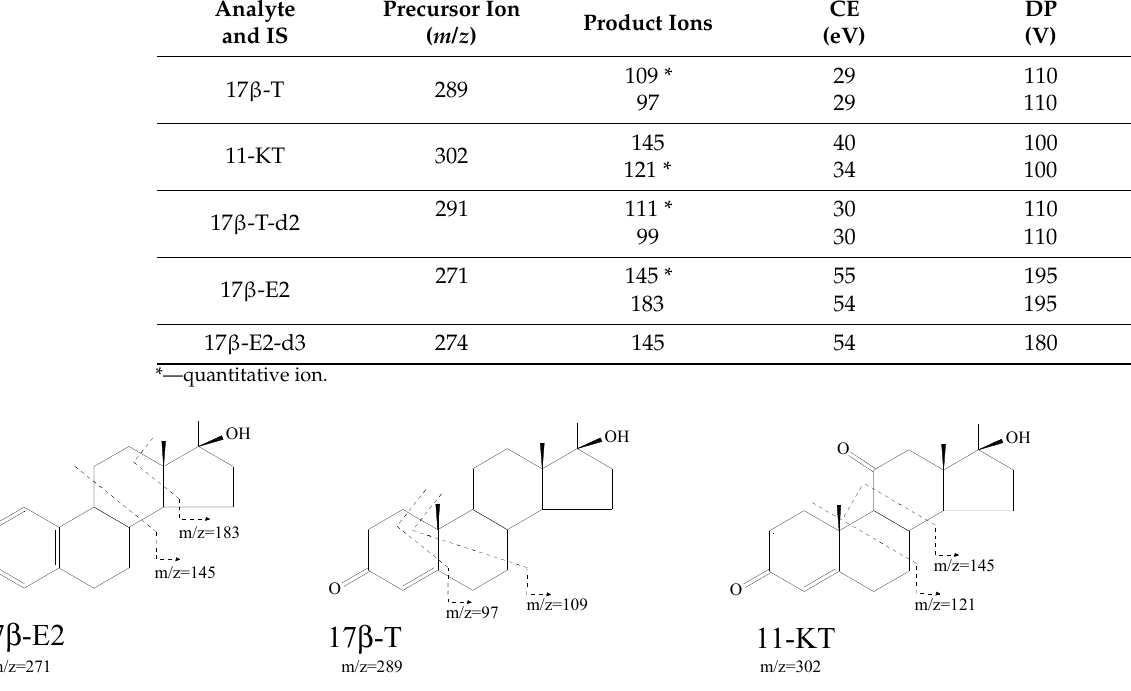
Figure 3. Proposed schemes of fragmentation of 17 β -E2, 17 β -T and 11-KT molecules. The optimum chromatographic condition was achieved using a mobile phase of acetonitrile- methanol-water (20:50:30, v / v / v ) eluted isocratically at a flow rate of 0.2 mL/min and the total run time for sample analysis was 14 min. The chromatographic conditions allowed the resolution of 17 β -T, 11-KT, 17 β -E2 and